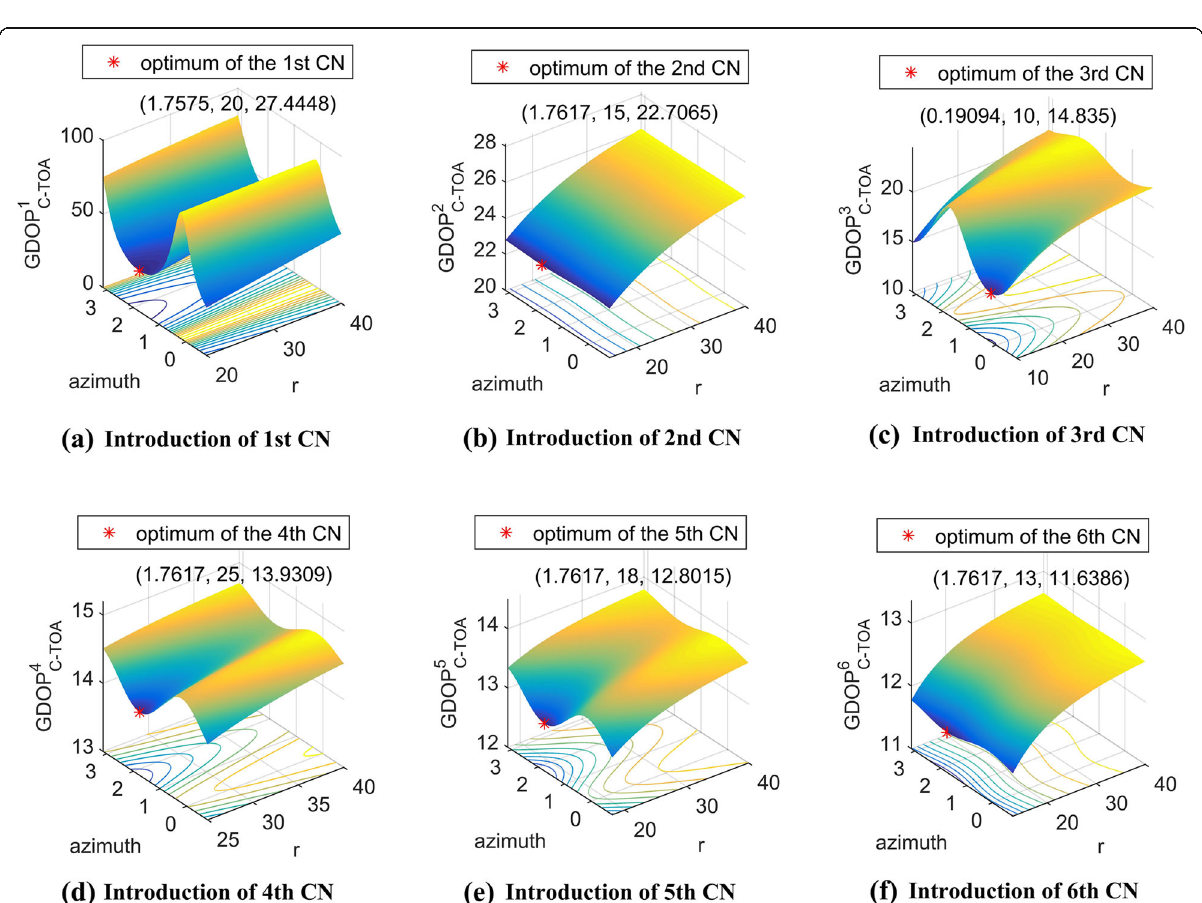
Fig. 7 Performance of partial exhaustive method towards AOA-based system in environment 3. a Introduction of first CN. b Introduction of second CN. c Introduction of third CN. d Introduction of fourth CN. e Introduction of fifth CN. f Introduction of sixth